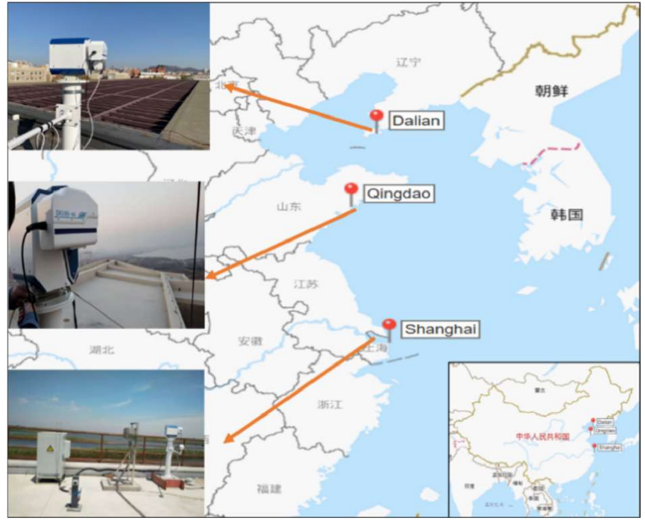
Figure 1. The locations of multi-axis differential optical absorption spectroscopy (MAX-DOAS)